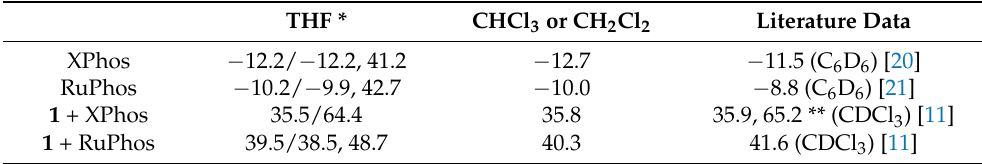
Table 5. 31 P chemical shifts (ppm) of XPhos, RuPhos and their mixtures with 1 . THF *